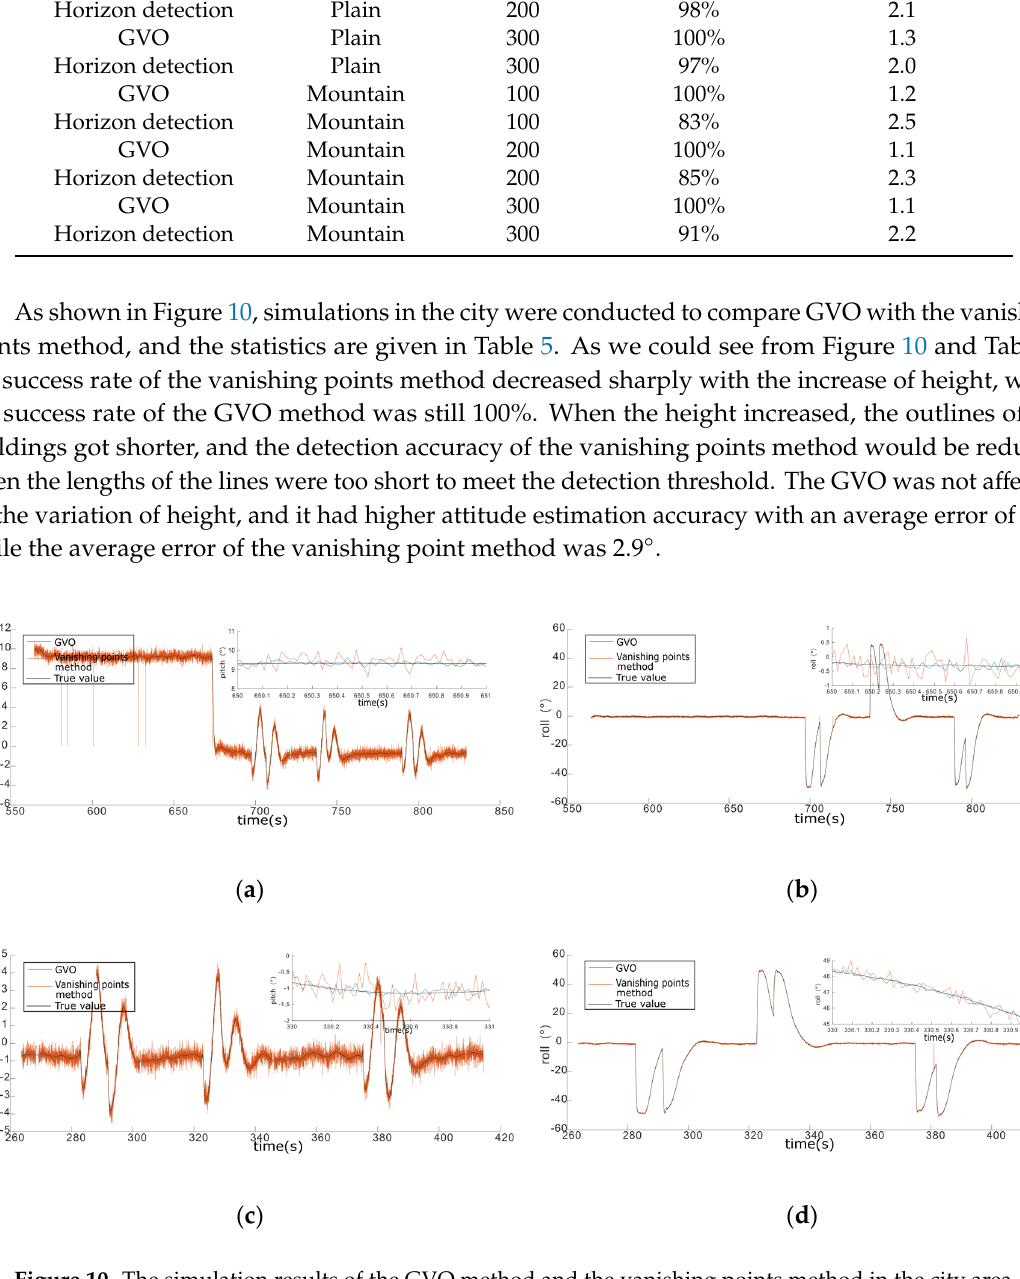
Figure 10. The simulation results of the GVO method and the vanishing points method in the city area. ( a ) Pitch angle of 100 m height. ( b ) The roll angle of 100 m height. ( c ) Pitch angle of 200 m height. ( d ) The roll angle of 200 m height. Table 5. Comparison between GVO and vanishing points method.